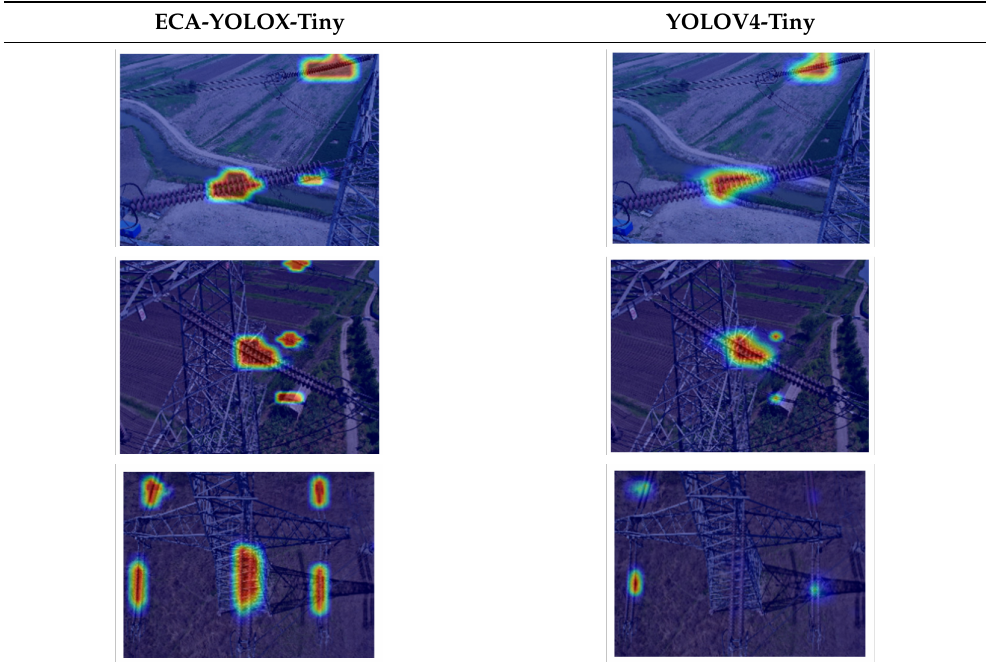
Table 11. The heatmap visualization of different models for multi-target normal